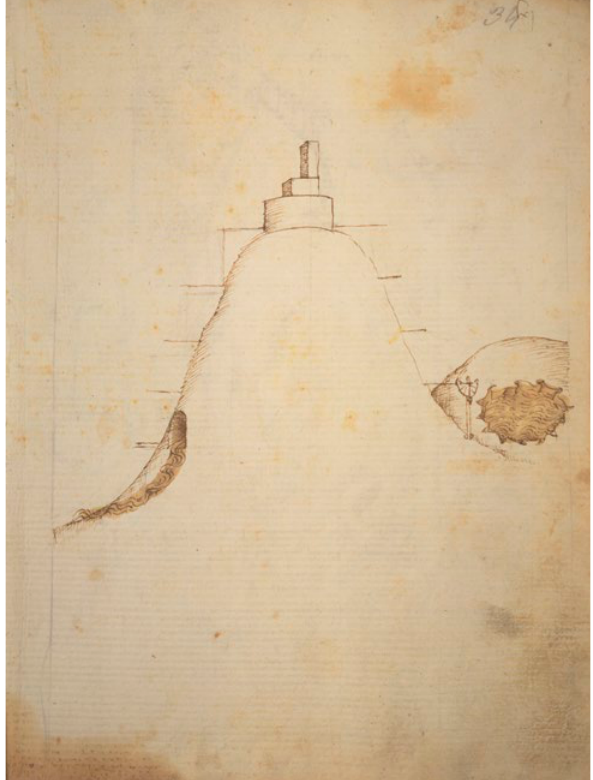
Figure 25. C.A., fol. 90v: canal with kiddles and